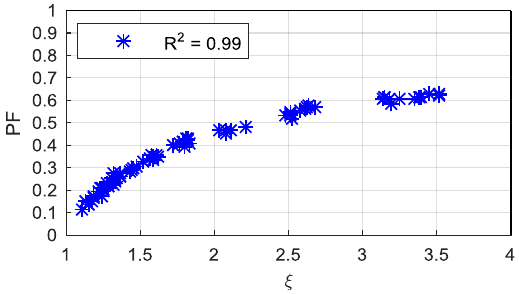
Figure 21. Power factor ( PF ) versus saliency ratio ( ξ ).